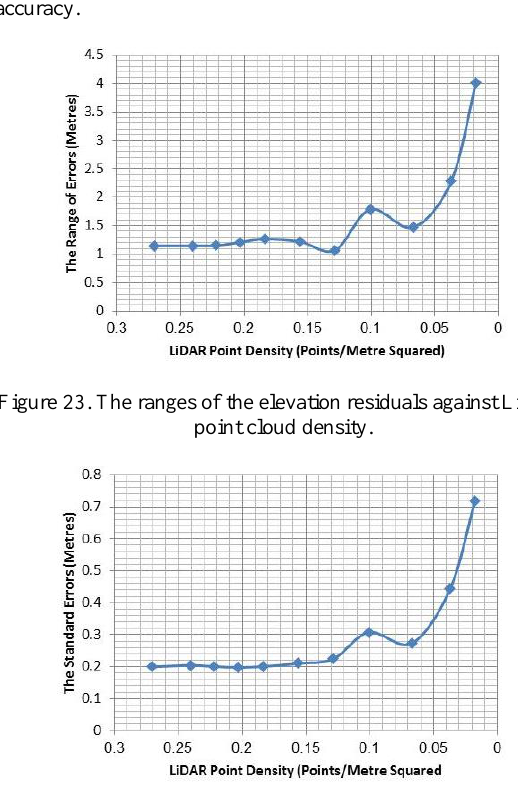
Figure 24. The standard errors of the elevation residuals against LiDAR point cloud